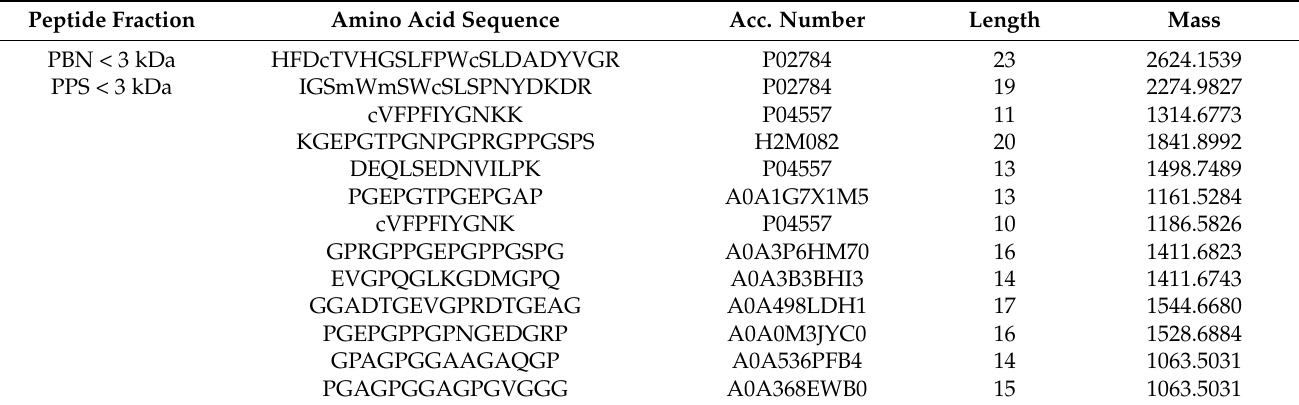
Table 2. Amino acid sequences of peptides in the PBN and PPS fractions of <3 kDa. Peptide